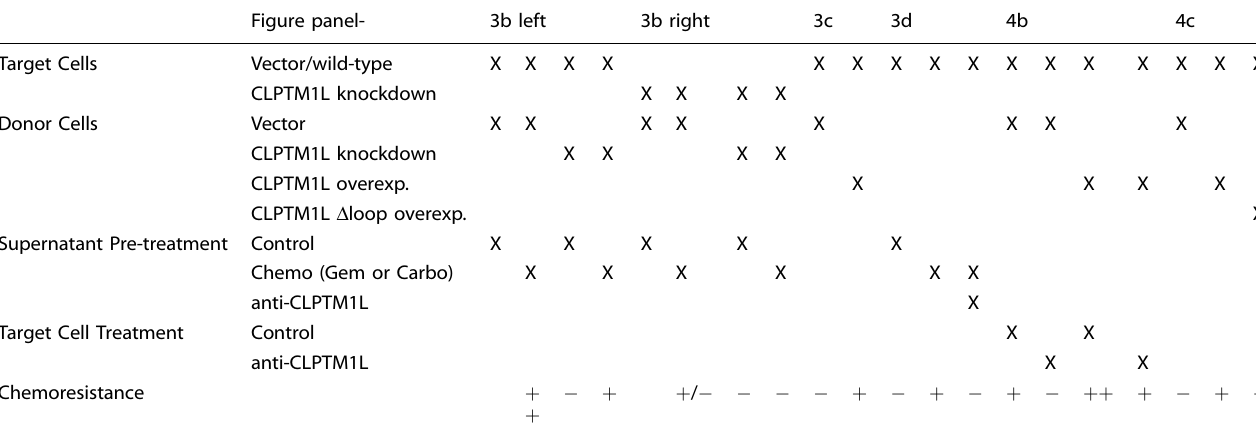
Table 1. Summary of chemosensitivity data from Figs. 3 and 4. Figure panel- 3b left 3b